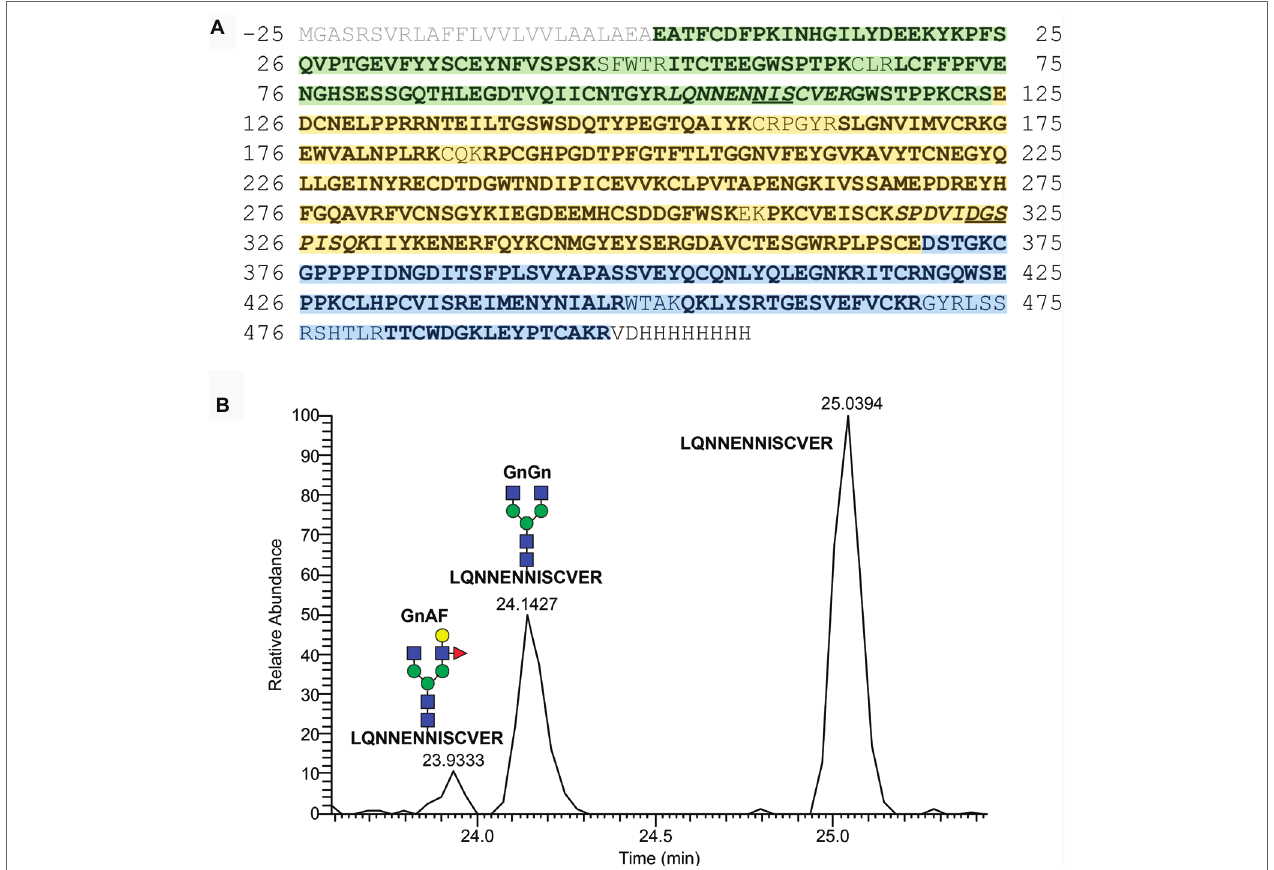
FIGURE 4 | Sequence and domain structure of MFHR1 and mass spectrometric sequence and N-glycosylation analyses. (A) Mature MFHR1 sequence (black) fused to the AP1-signal peptide (grey). The amino acid positions relating to the mature protein are given. Negative numbers refer to the signal peptide. The amino- terminal portion of MFHR1 is composed of the first two SCRs of FHR1 (green), followed by the catalytically active SCRs 1-4 from FH (yellow). The C-terminus includes the surface-binding SCRs 19-20 from FH (blue) followed by a His-tag. Peptides identified by mass spectrometry are shown in bold and the putative N-glycosylation site NIS (Asn108) and the deamidated site DGS (Asn323 ➔ Asp323), are underlined, corresponding mass spectrometric detected tryptic peptides are shown in italics. (B) Elution profiles (extracted ion chromatogram, EIC) of the tryptic peptide ( 102 LQNNENNISCVER 113 ) which flanks the glycosylation site NIS (Asn108) with and without N-glycosylation. Peak identity was confirmed by m/z-value and charge state on MS1- and by reporter ions on MS2-level (see Supplementary Figure 4 for further information). Peak quantification revealed an N-glycan occupancy at Asn108 of 35%, which in total consisted of 86% GnGn − , nearly 14% GnAF structures and < 1% of N-glycans with terminal mannoses, all of them lacking plant specific core xylose and fucose. For the deamidated site (Asn323 ➔ Asp323) no N-glycosylation was detectable. Gn: N-acetylglucosamine, A: galactose, F: Fucose – referring to the terminal sugar